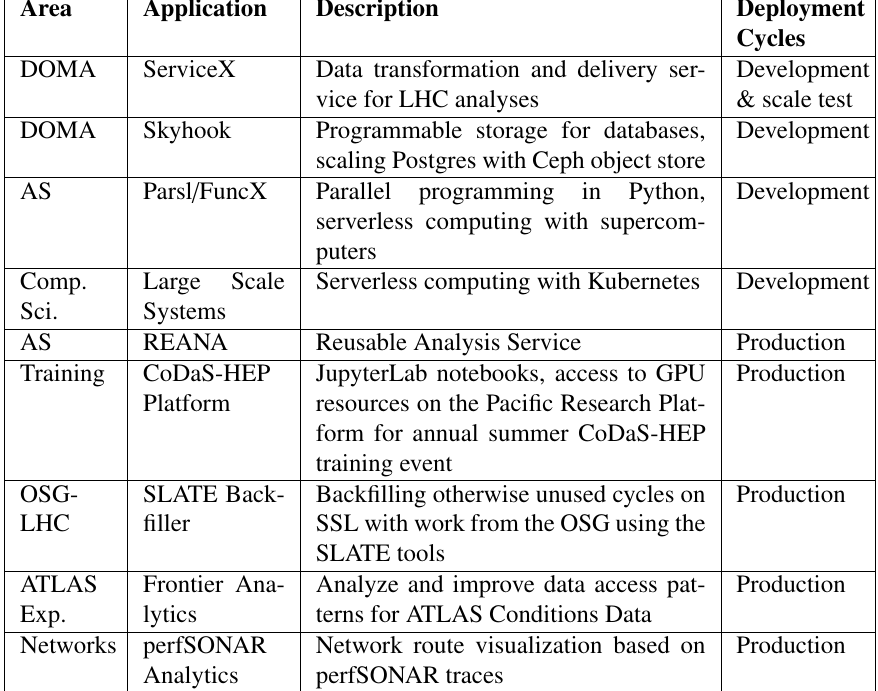
Table 1: Applications and services deployed on the IRIS-HEP SSL resource.